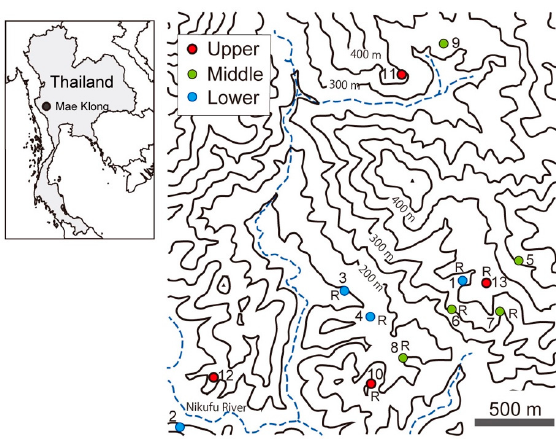
Figure 1. Location of soil survey pits at the Mae Klong Watershed Research Station, Kanchanaburi, Thailand. Red circles, green circles, and blue circles indicate upper, middle, and lower slope positions, respectively. The location of root sampling sites is indicated by “R”. The blue dotted line is the primary stream channel of the Nikufu River.